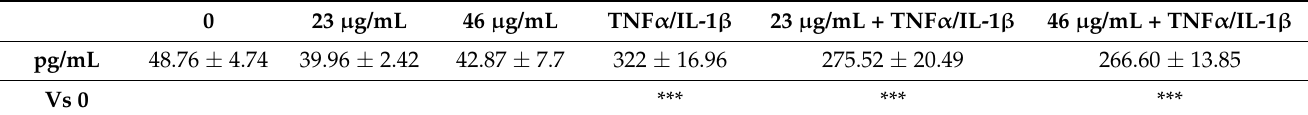
Table 2. Concentration (pg/mL) of IL-8 secreted in the basolateral media at the different conditions.